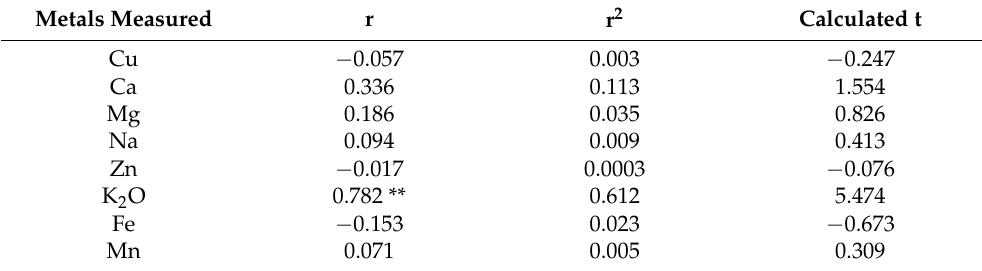
Table 6. Results of linear correlation analysis of electrical conductivity measurements with respect to concentrations of metals that could potentially be in chloride salt form (r = correlation coefficient; r 2 = coefficient of